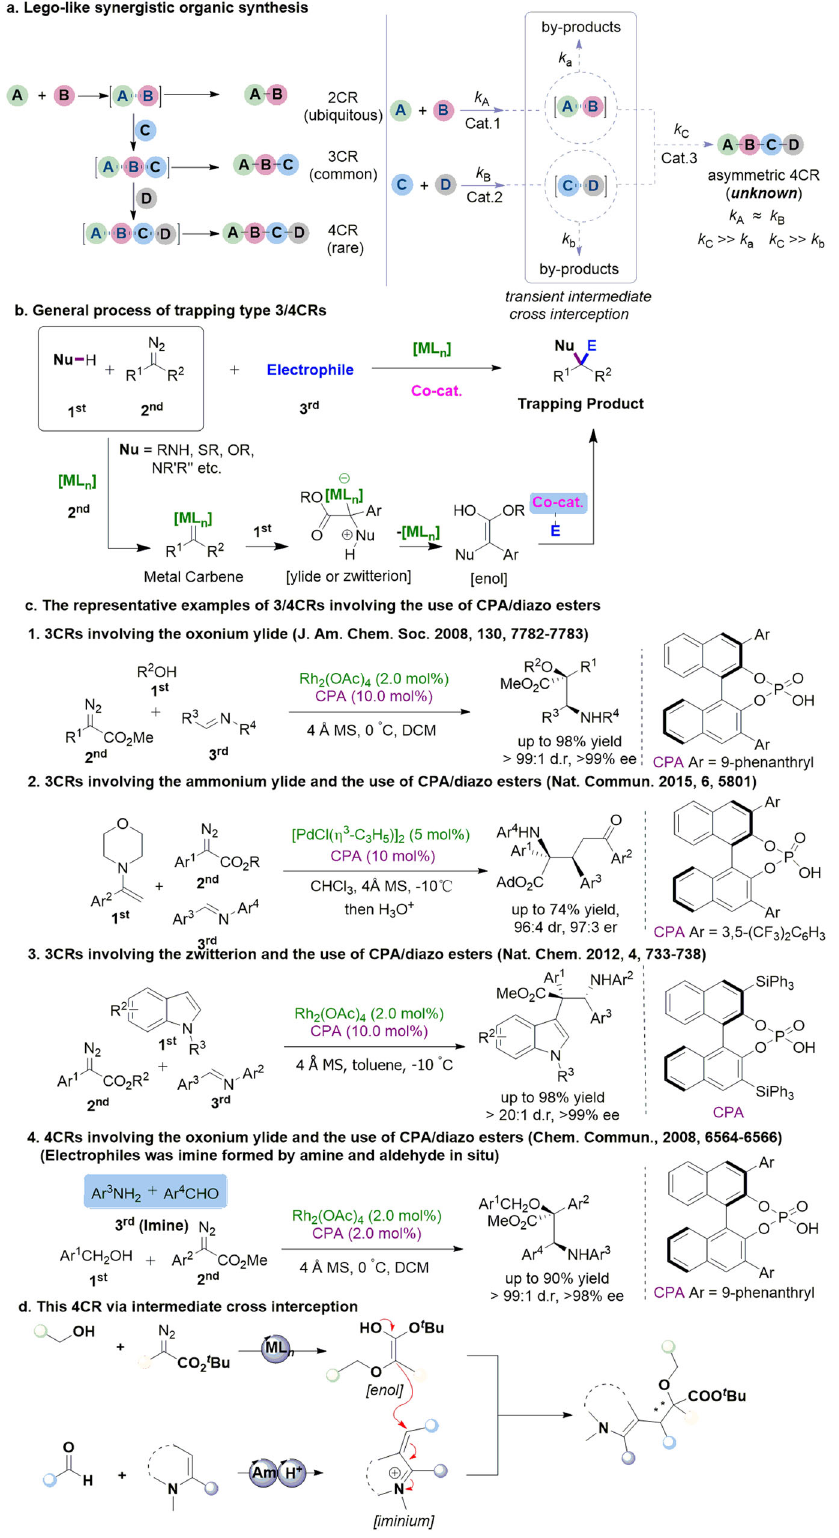
Fig. 1 | Patterns of chemical reactions. a Lego-like synergistic organic synthesis. b General process of trapping type MCRs developed by our group. c The repre- sentative examples of3/4CRsinvolving the useof CPA/diazoesters. d This 4CRvia